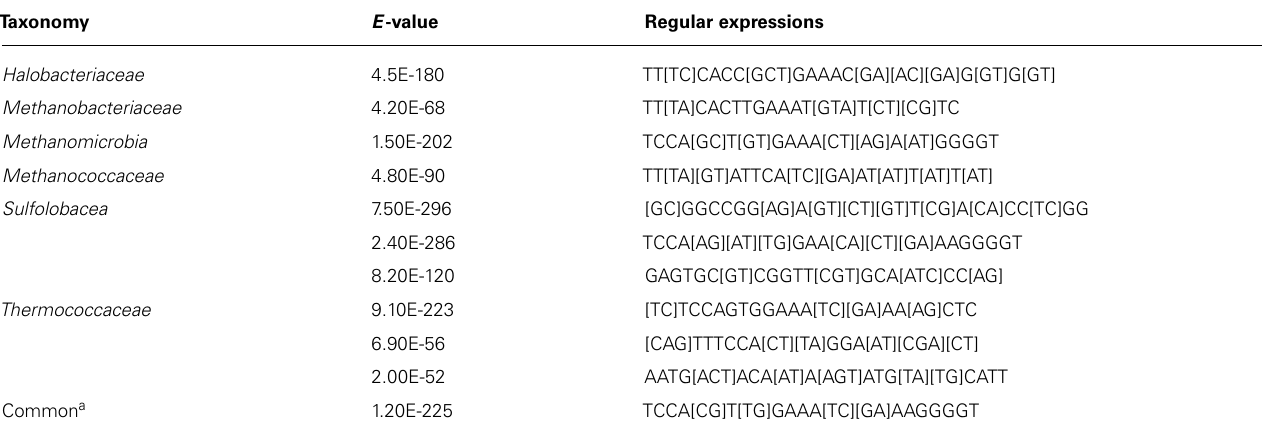
Table 1 |The regular expressions of the ORB motifs identified by MEME.